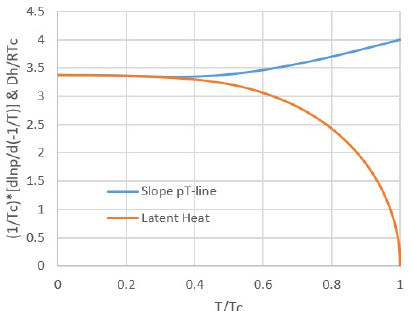
Figure 3. Latent heat van der Waals fluid (orange) and slope of the pT-line (blue) as a function of temperature. For temperatures up to about 50% of the critical temperature, both are nearly constant with temperature and hardly differ. Hence for lower temperatures, the latent heat Δ h can be considered constant, confirming the assumption for integrating the Clausius-Clapeyron equation.